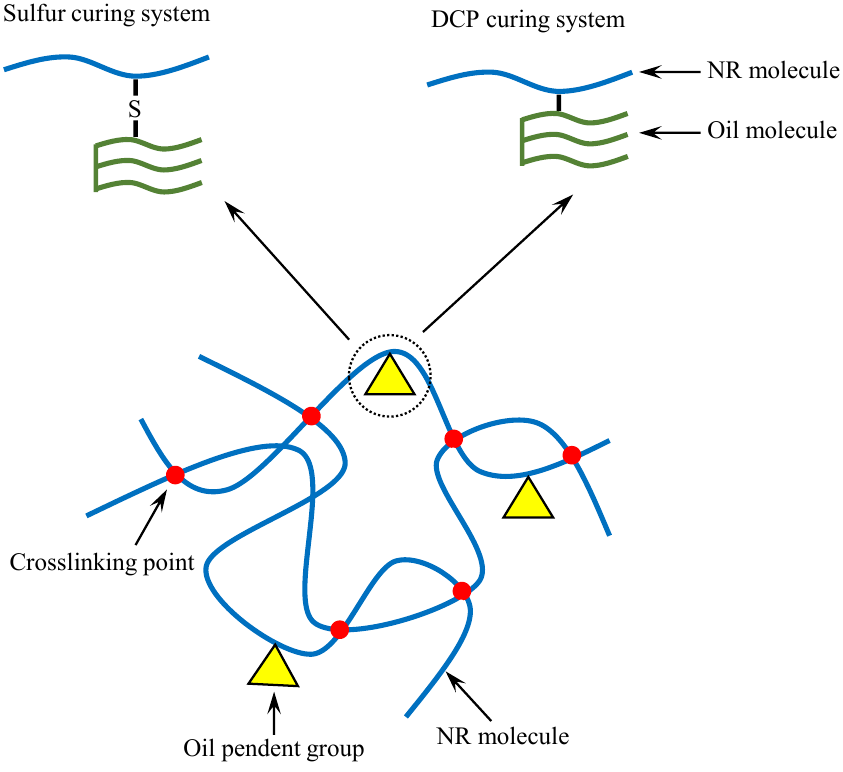
Figure 10. Proposed model for the representation of bio-oils, i.e., PO and SBO, in the rubber com- pounds cured with different curing systems.